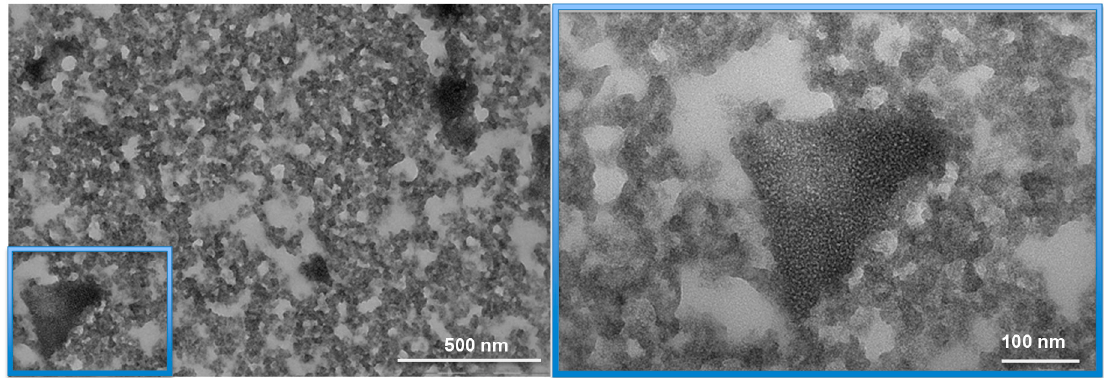
Figure 13. Nitrogen sorption isotherms at 77 K of as-synthesized ( a ) and solvent-extracted ( b ) mesoporous silica monoliths (aerogels-like materials) prepared with 178 H 2 O and high amount of surfactant-polymer DM-970.